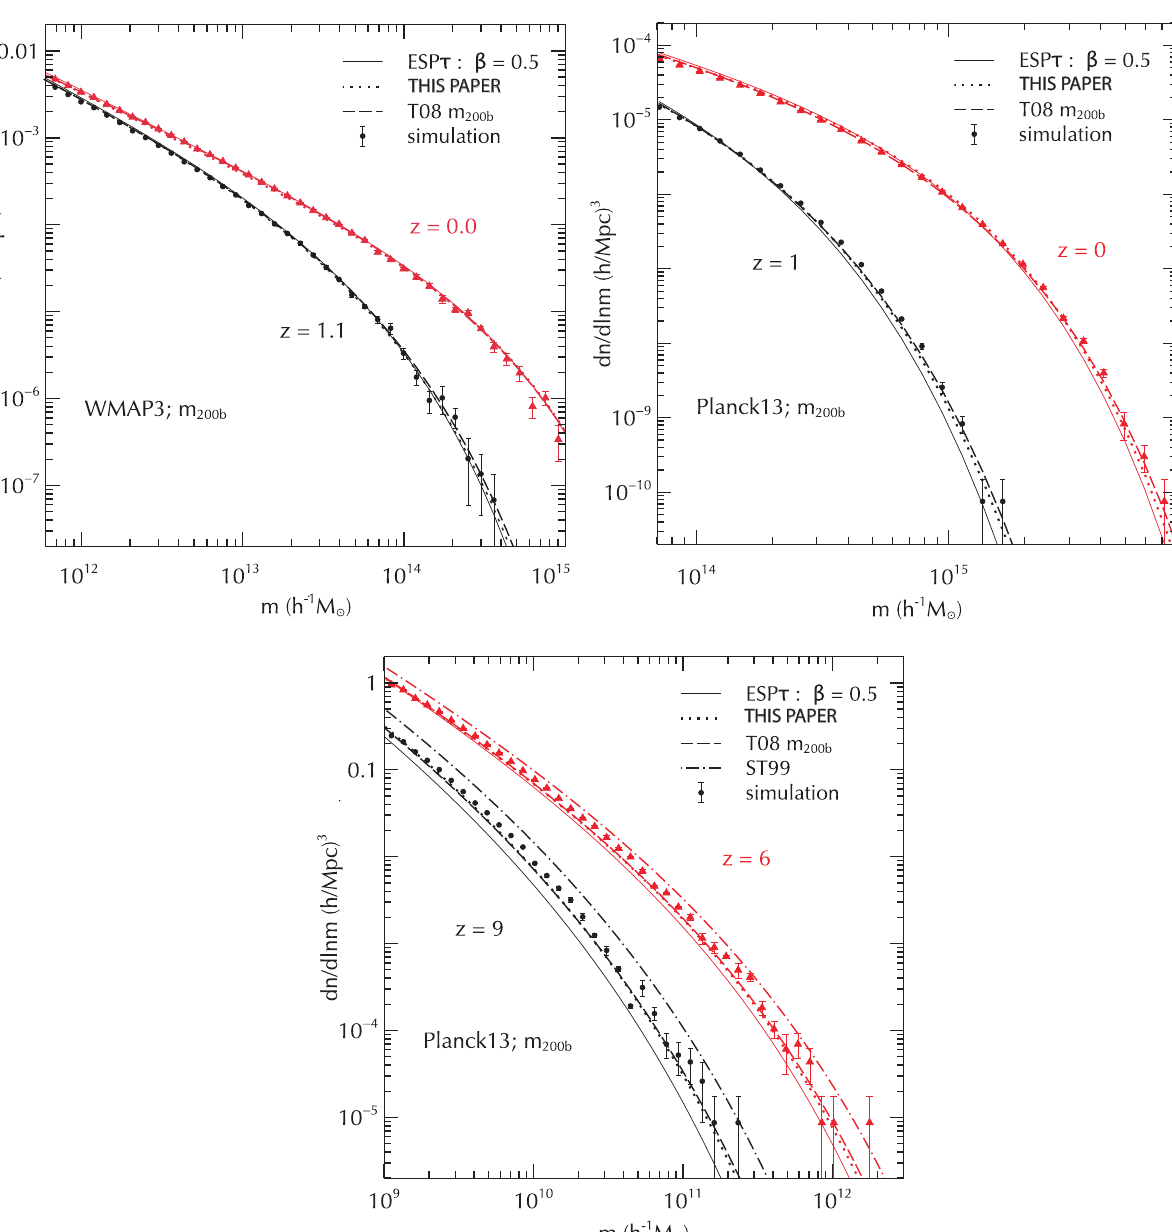
plot in the bottom panel represents the same quantities for z = 6, and z = 9. The dot-dashed line represents the ST1 MF. Figure 4, confirms the previous results. ST mass func- tion overpredicts the simulations MF, while T08 is in good agreement with them. Castorina et al. (2016) MF underpre- dicts the halo abundance, and the problem increases with